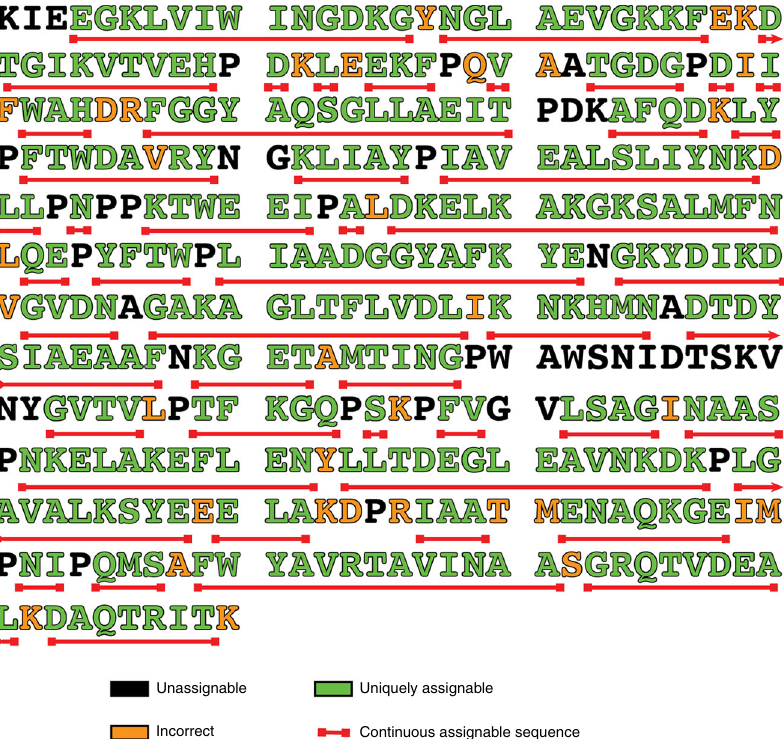
Fig. 5 Primary structure of MBP showing the extent of assignable residues from a single HNCA experiment. Using high-resolution information along with peak correlation matching, 85% of the sequence is sequentially assignable (green). Incorrect assignments are colored orange. The long stretches of sequentially assignable sequence are underlined in